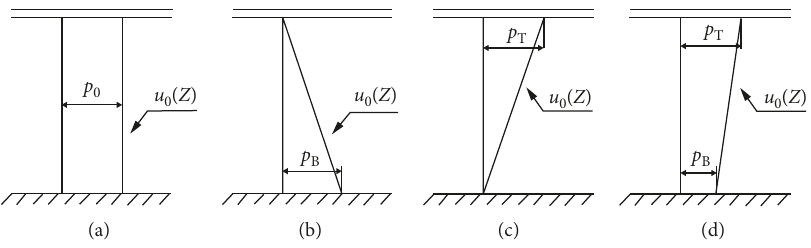
Figure 2: Nonuniform distribution of initial excess pore water pressure along depth. (a) Rectangular. (b) Positive triangle. (c) Inverted triangle. (d)